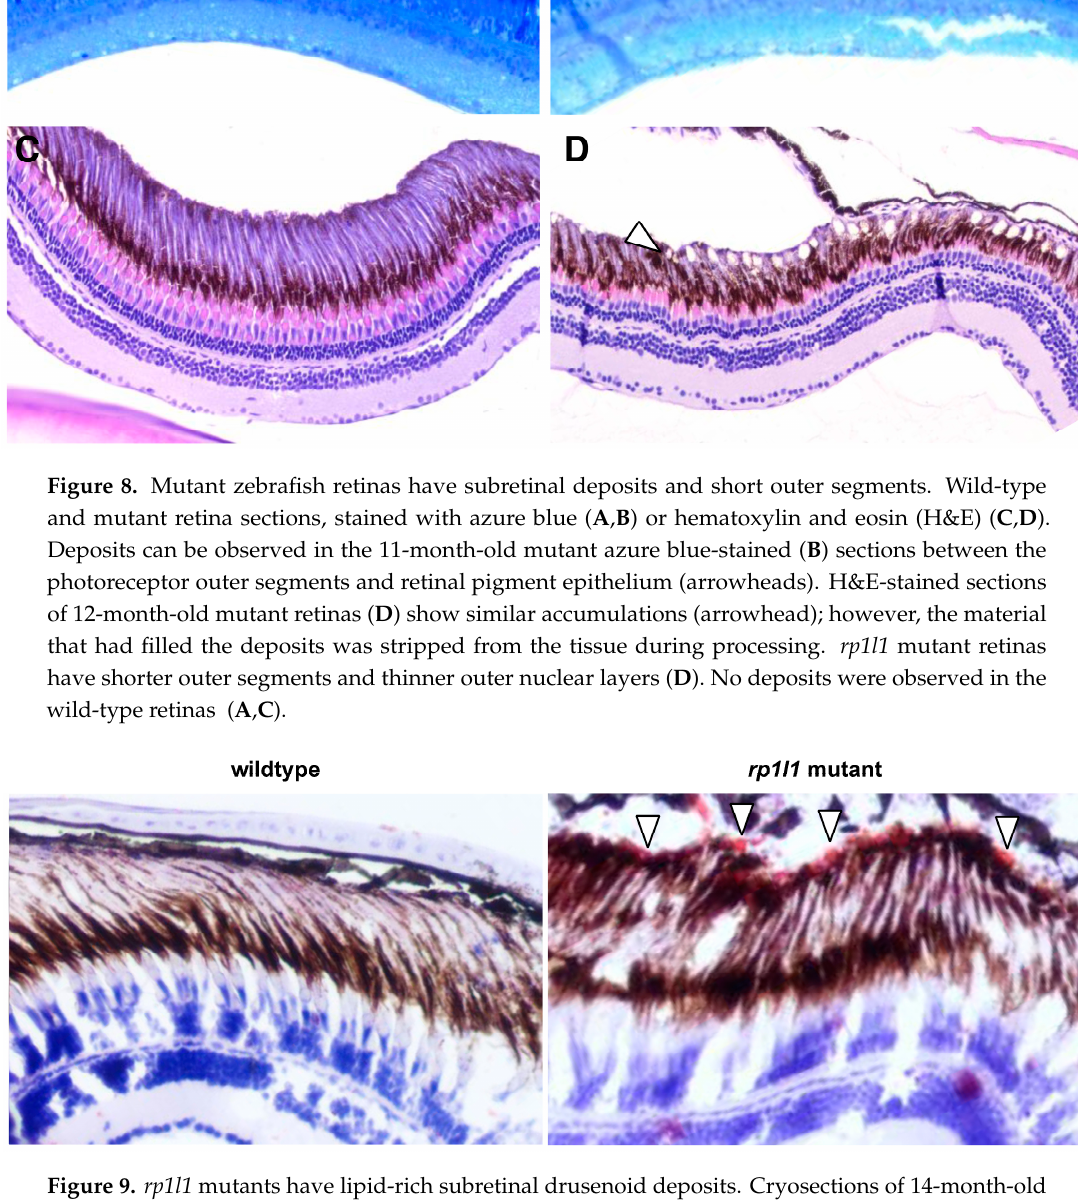
Figure 9. rp1l1 mutants have lipid-rich subretinal drusenoid deposits. Cryosections of 14-month-old wild-type and mutant zebrafish retinas, treated with Oil Red O to stain lipids and hematoxylin to stain nuclei (blue). The deposits in the mutant retina stained red (arrowheads), demonstrating that they are lipid-rich.